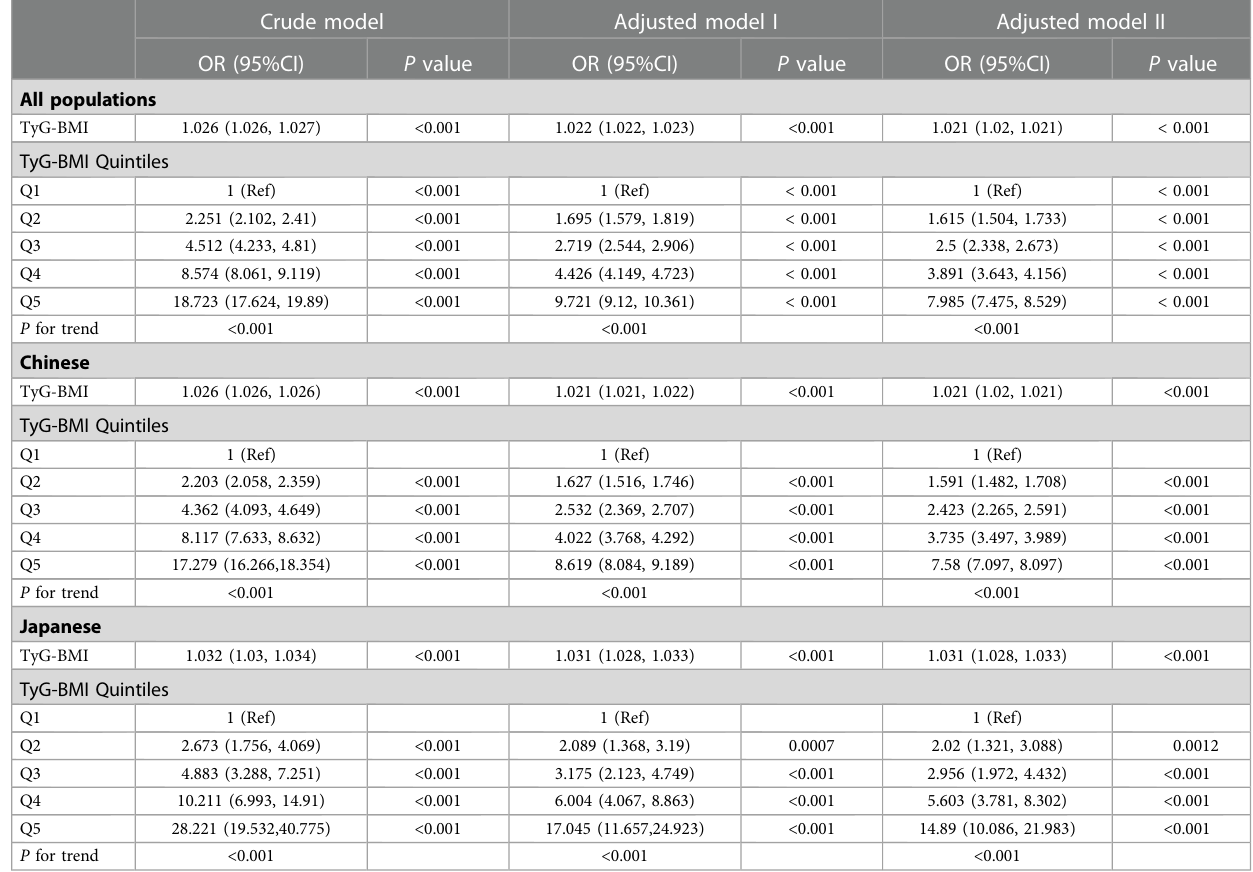
TABLE 3 Logistic regression analysis of the relationship between TyG-BMI and